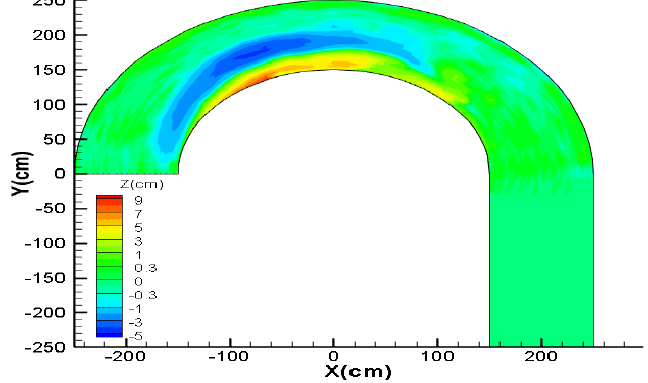
Figure 6. Bed topography variations in the case of empty bend (without a